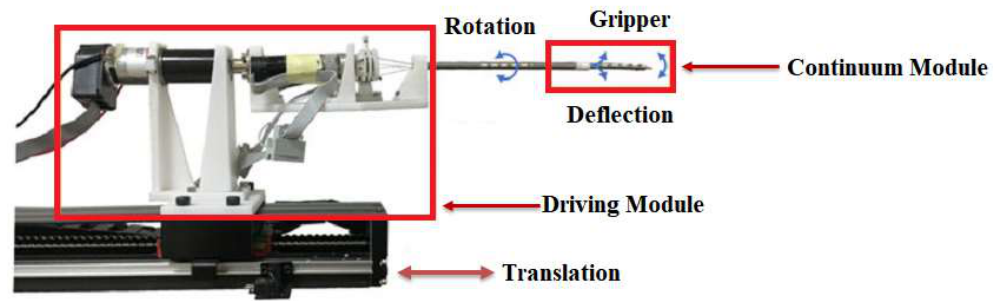
Figure 6. Fundamental drivers of the slave manipulator.